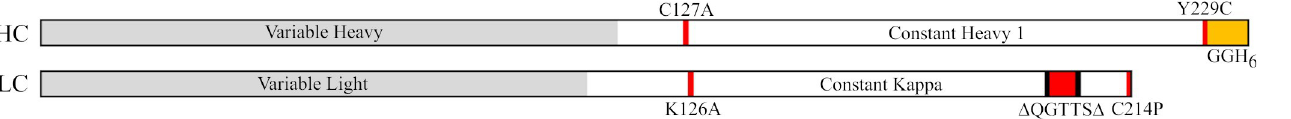
Table 2. Crystallization of two fabs and their variants.